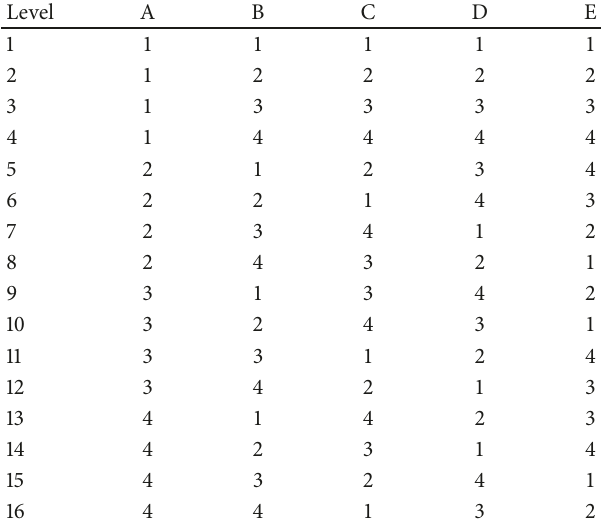
Table 2: Proposed L 16 orthogonal